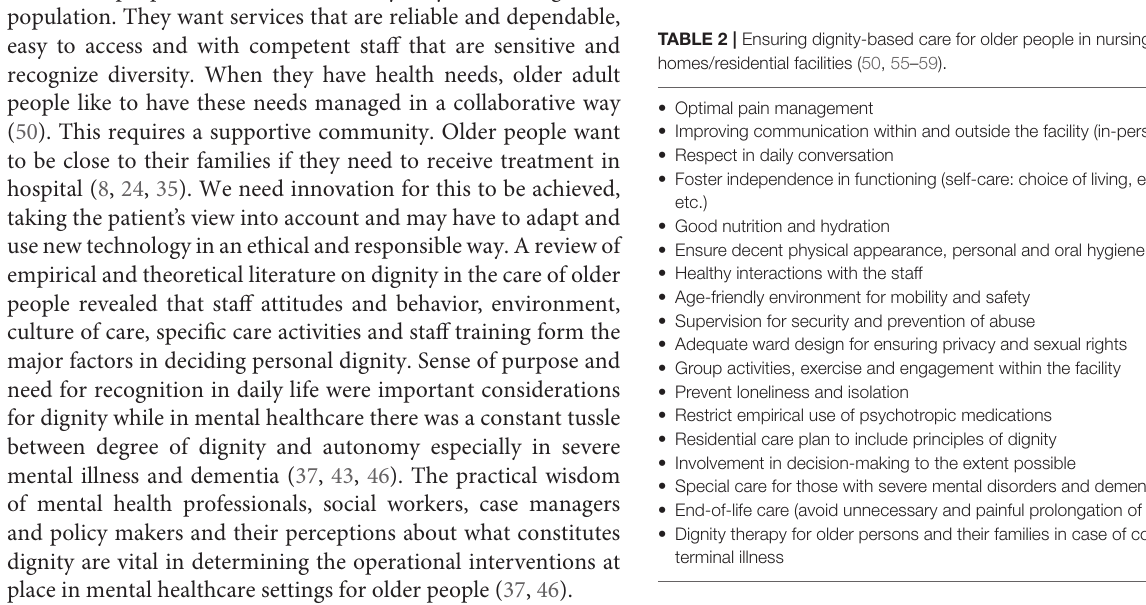
and their caregivers - Focus on respectful communication and social recognition as “individuals” (rather than patients) - Inclusion of older people with mental illness/their families in interventions and policies - Work with other sectors of society (justice, welfare, security forces, economy, etc.) to promote protection against ageism and to prevent ageist